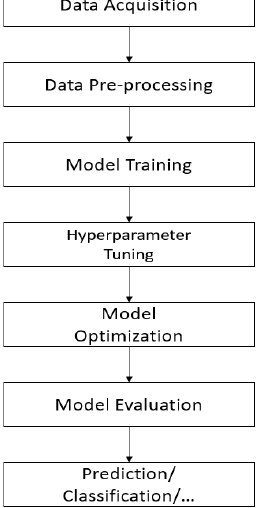
Figure 6. AI smart model workflow.